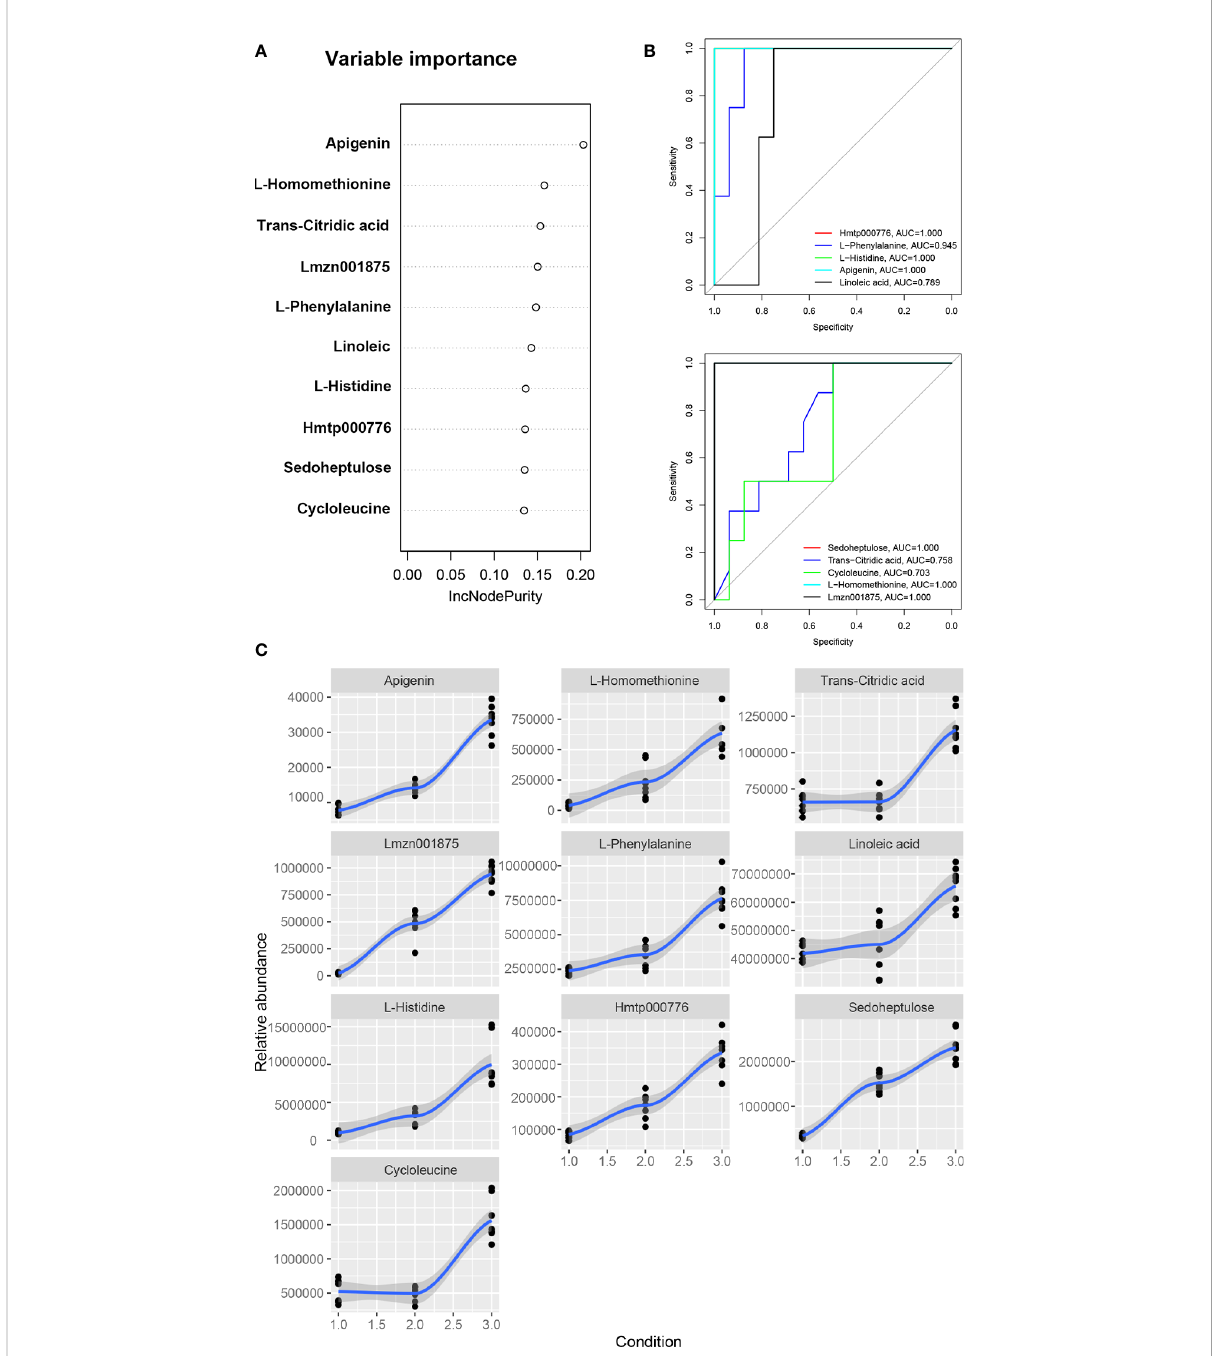
FIGURE 5 Machine learning and receiver operating characteristic curve analysis. (A) The random forest model was used to screen 10 metabolic biomarkers for Draba oreades Schrenk at different altitudes. (B) ROC curves of biomarkers. (C) Relative abundance trend charts of 10 biomarkers at different altitudes. The abscissa 1.0 represented low-altitude, 2.0 represented mid-altitude, and 3.0 represented high-altitude. Lmzn001875: Naringenin- 7-O-Rutinoside-4 ’ -O-glucoside, Hmtp000776: